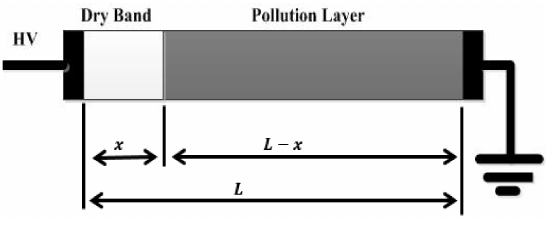
Figure 2. Single dry band near high voltage